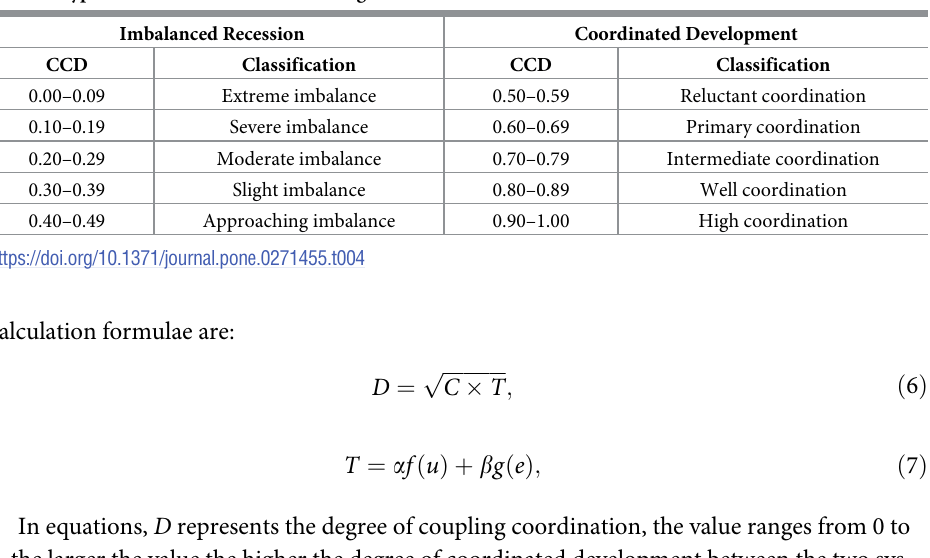
Table 4. Types of CCD between ULEE and digital